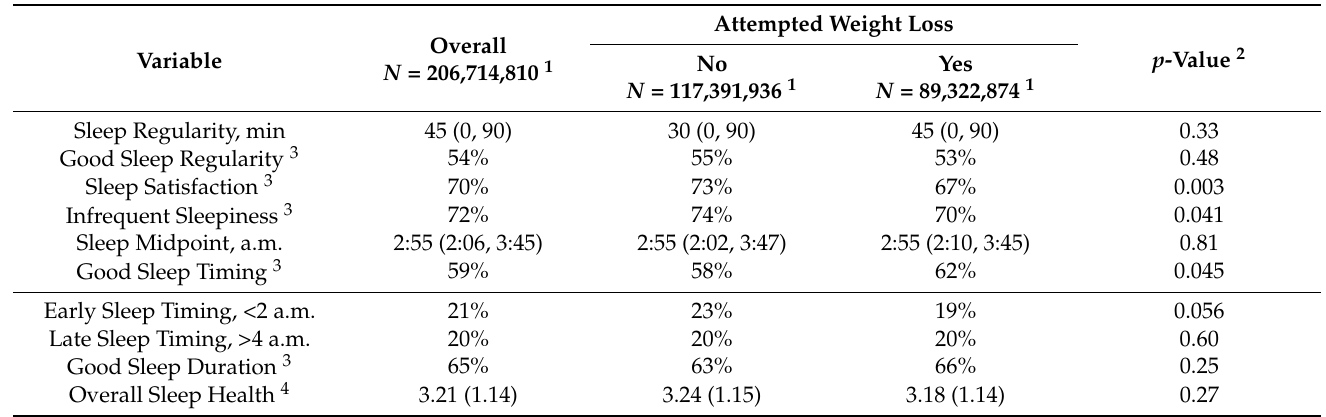
Table 2. Sleep health characteristics by weight loss attempt status.